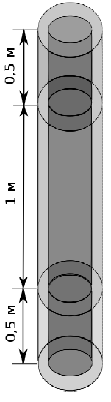
Fig. 1. The fuel rod